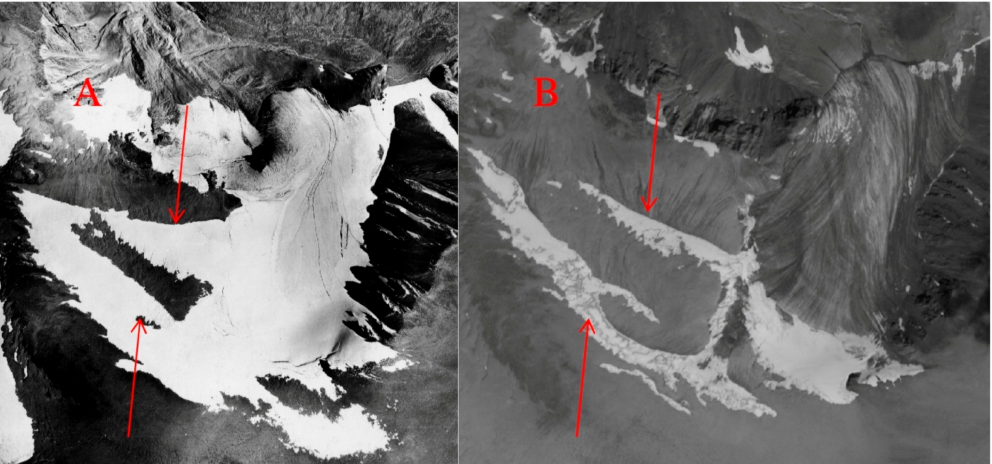
Figure 12. Degradation of Argamgi-2—Eastern Glacier, the northern slope of Tavan-Bogd. ( A ) Aerial image, (24 August 1962); ( B ) SPOT 5 satellite image (31 August